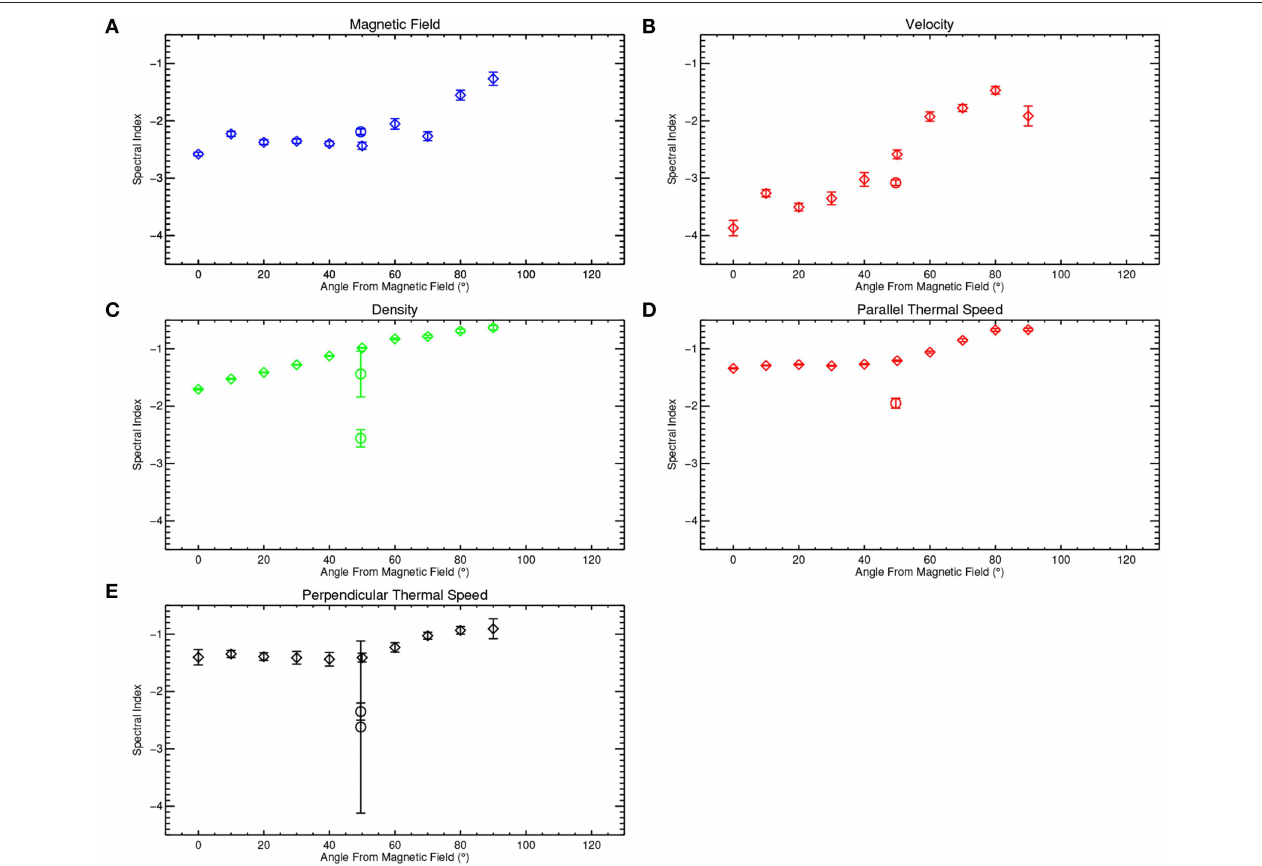
FIGURE 8 | Anisotropy of spectral indices, showing magnetic field (A) , ion velocity (B) , density (C) , ion parallel thermal speed (D) , ion perpendicular thermal speed. The diamonds show the points obtained from the integrations of the results in Figures 3 , 4 and the circles show the points corresponding to the one dimensional frequency spectra in Figure 2 . The two circular points in (C,E) denote the inertial range index and the kinetic range spectral index values. The error bars denote the error from the residuals of linear least squares fitting for log power against log